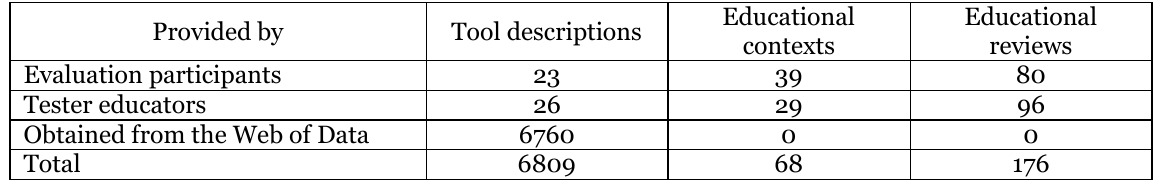
Data Available in SEEK-AT-WD Before the Second Part of the Evaluation Started Provided by